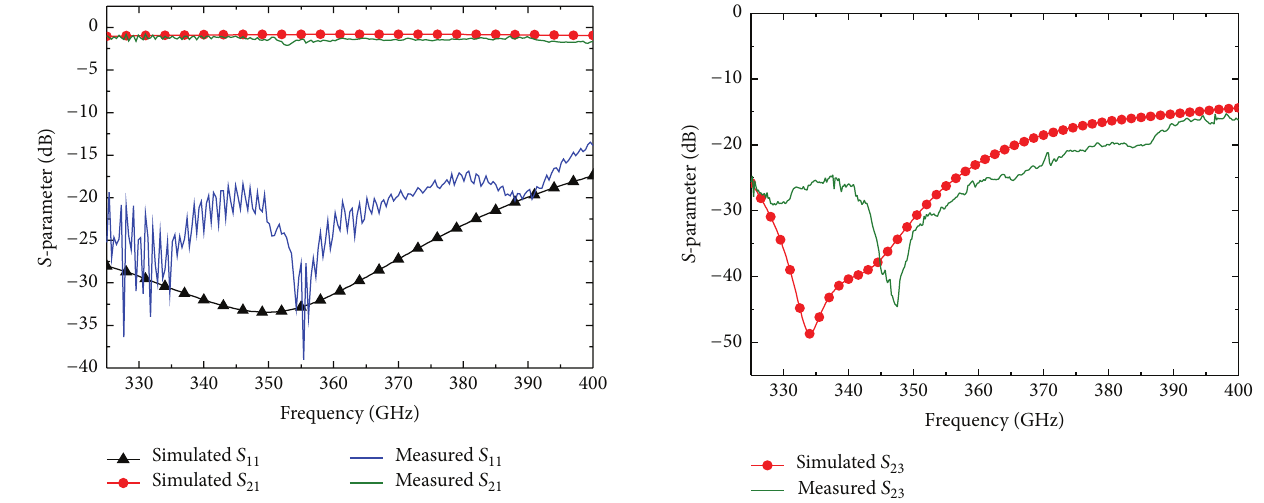
Figure 15: Measured 𝑆 -parameter compared with measured and simulated results of the isolation